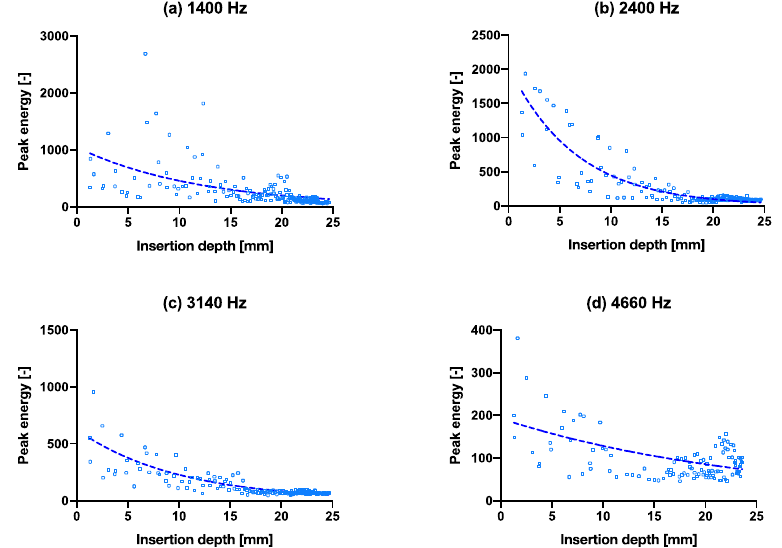
Figure 4. Capability of predicting insertion depth with frequencies by peak energy vs. insertion depth through the course of inserting the broach into the bone. ( a – d ) are the isolated peak energies (larger broach condition) for the four main peak frequencies at 1400 Hz, 2400 Hz, 3140 Hz and 4660 Hz, respectively, with exponential trend lines. The same graphs with hammer blows on the x -axis are shown in Supplementary Materials Figure S3. Table 2. Curve-fitting of Figures 4–6. The degree of convergence of the pitch consistency analogous to the goodness of fit (R 2 ) may suggest fixation quality.